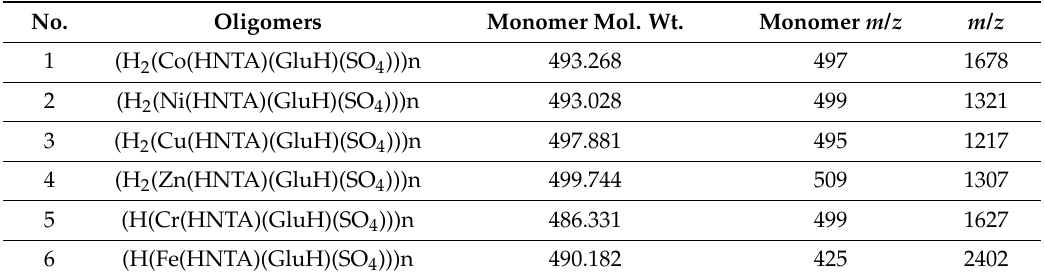
Table 3. Mass spectra data of the prepared coordination